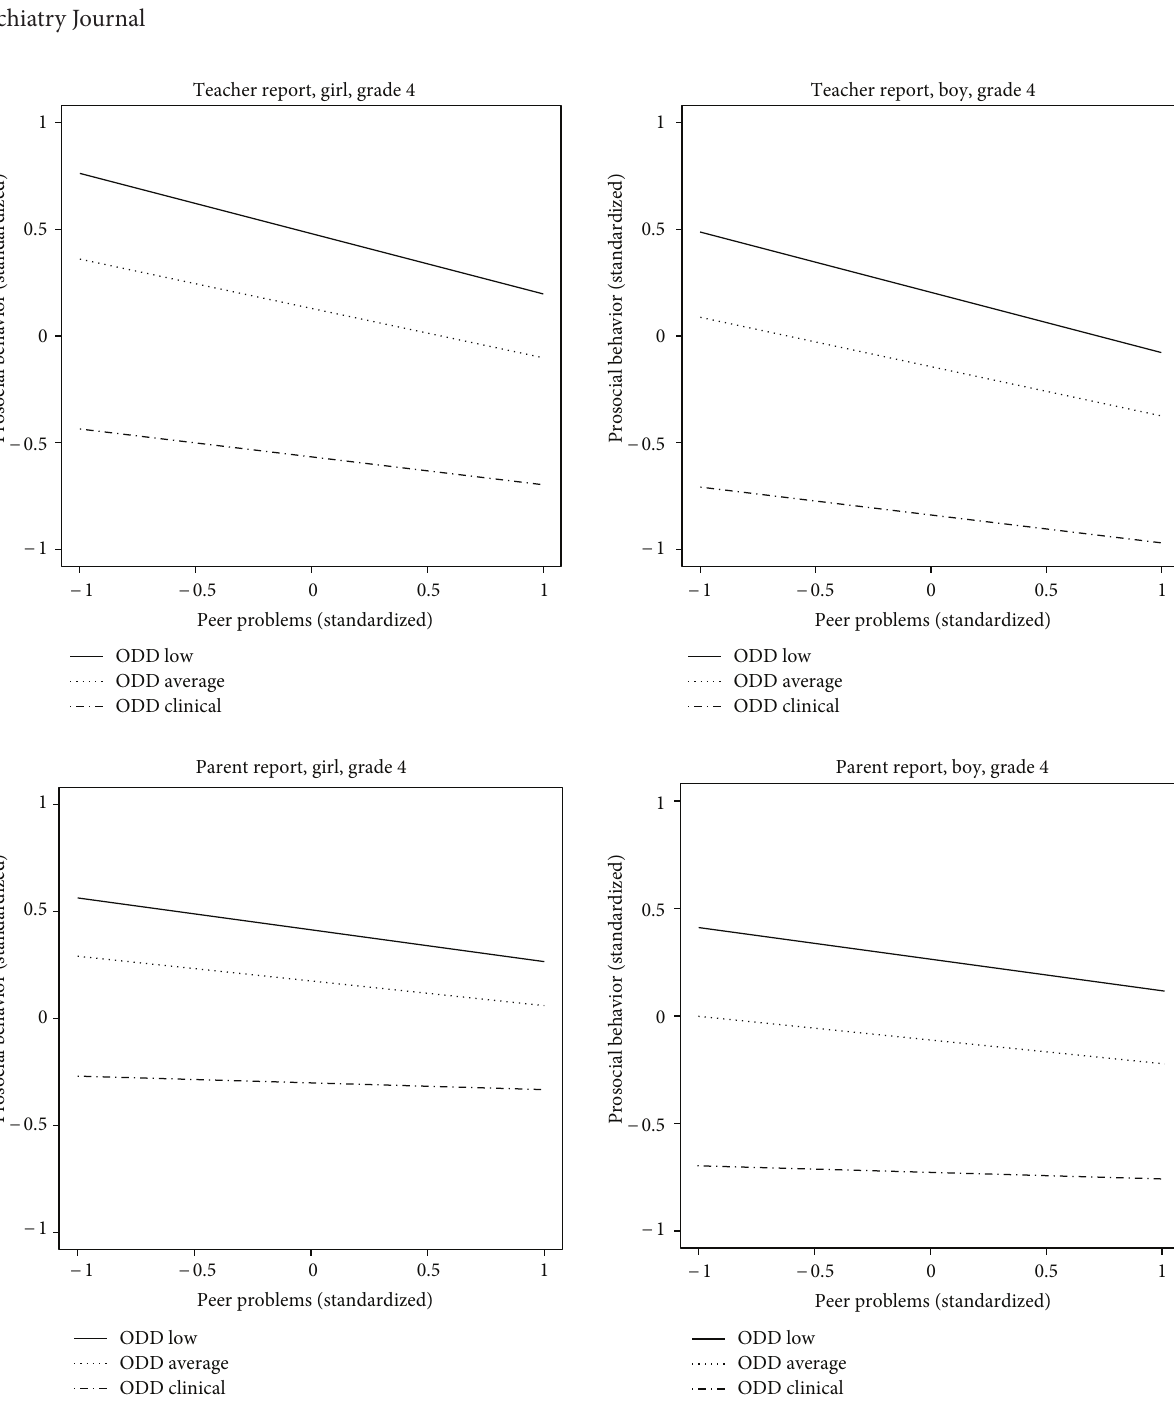
-axis) and prosocial behavior 𝑥𝑥